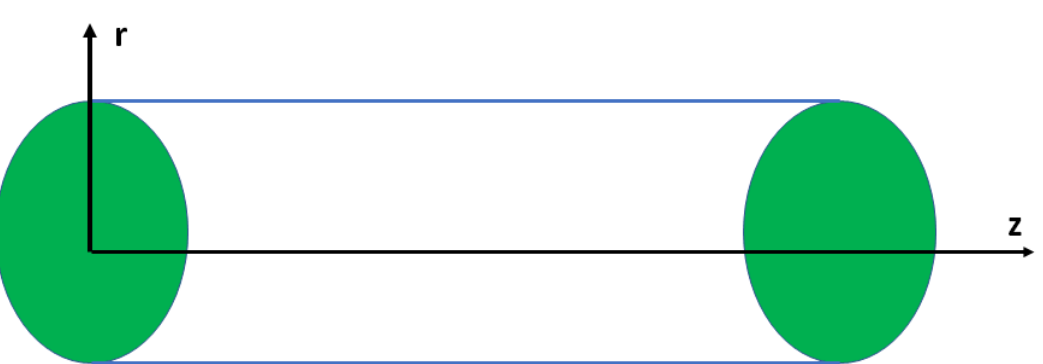
Figure 1. Domain definition for the circular